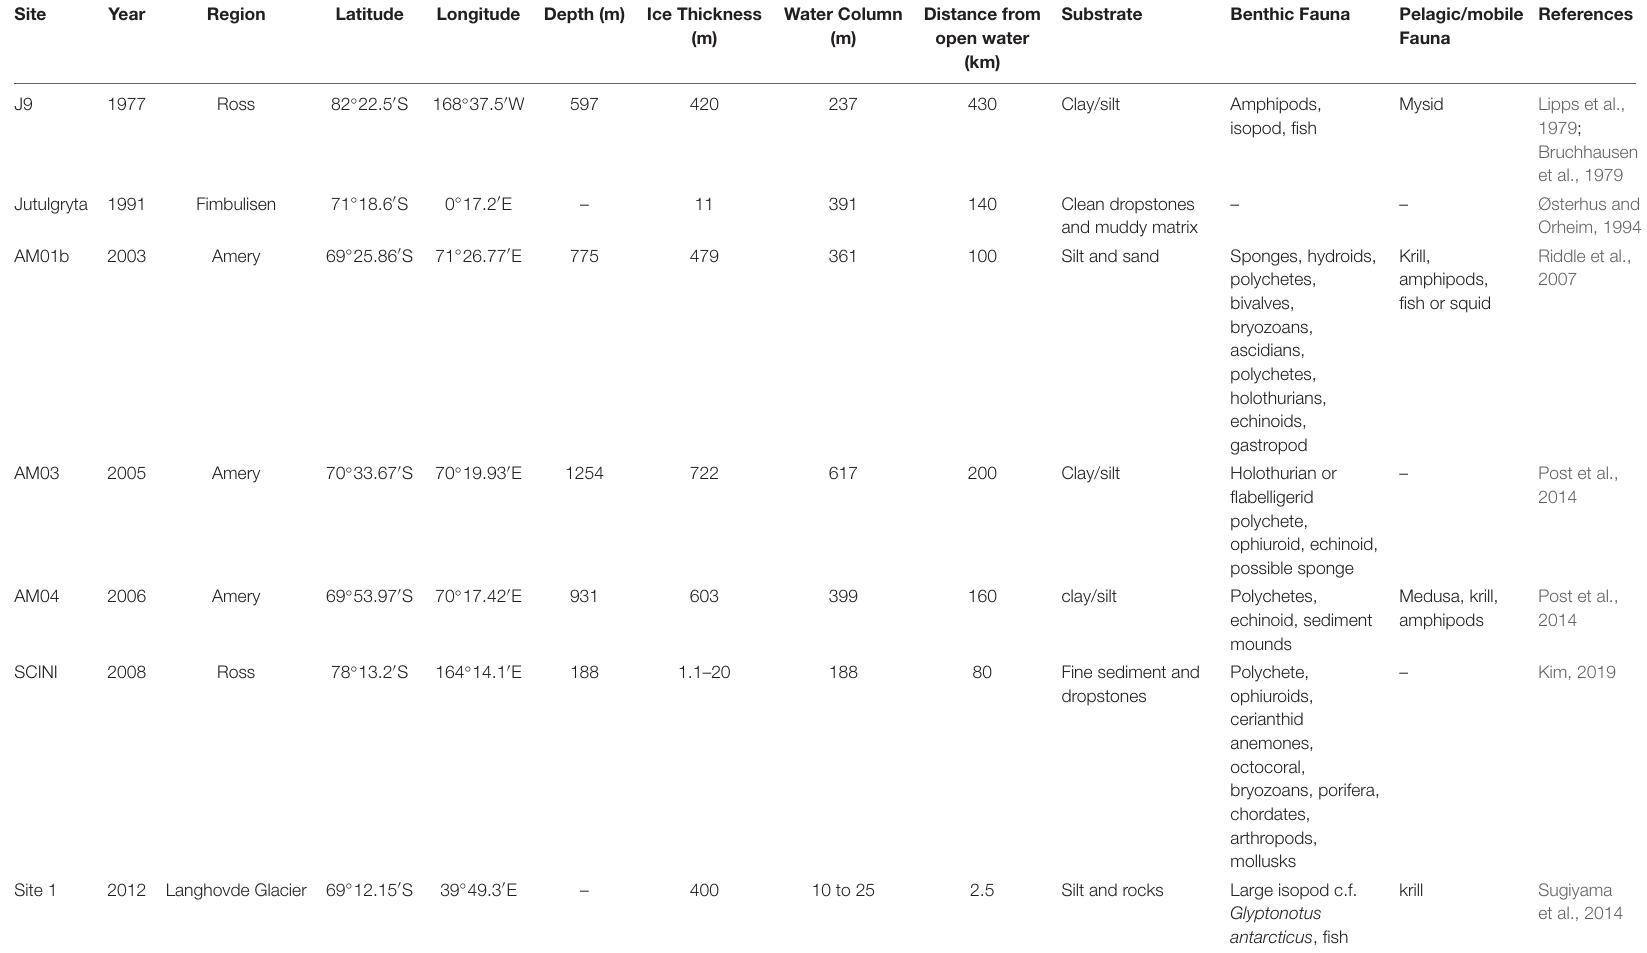
TABLE 1 | Details of Antarctic Ice Shelf boreholes that have seafloor images, including those with living